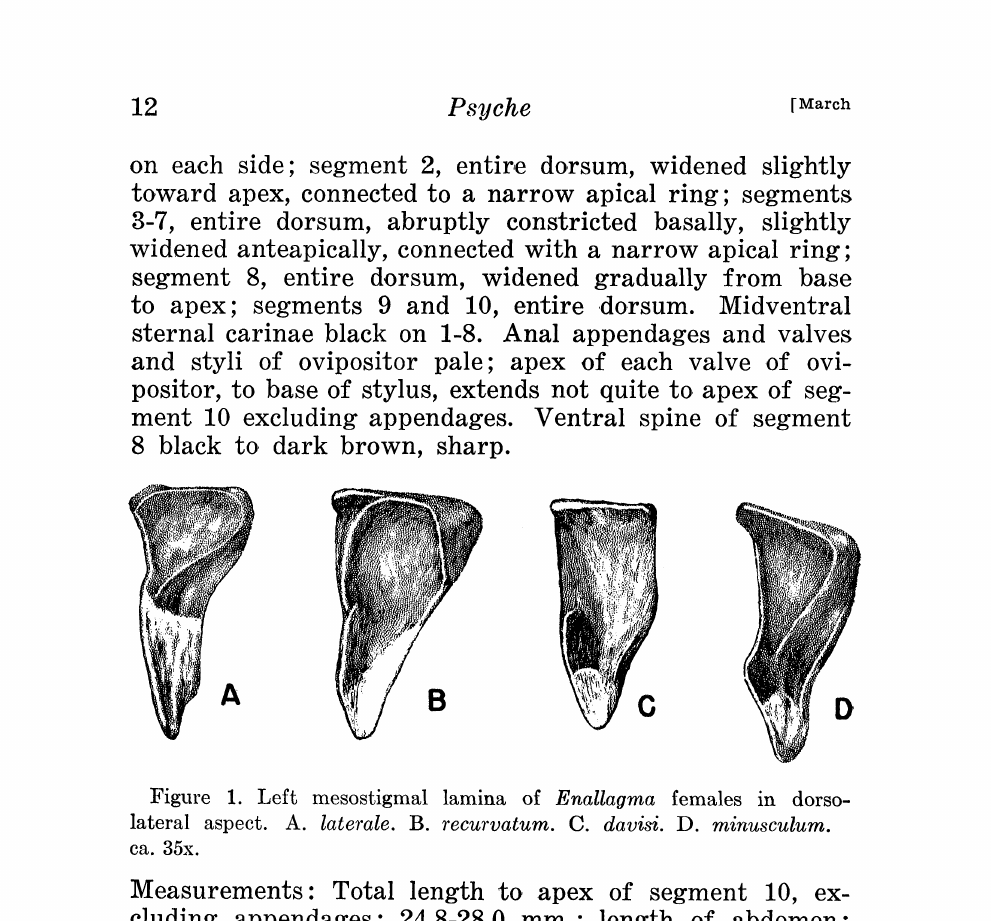
Figure 1. Left mesostigmal lamina of Enallagma females in dorso- lateral aspect. A. laterale. B. recurvatum. C. davisi. D. minusculum. c.